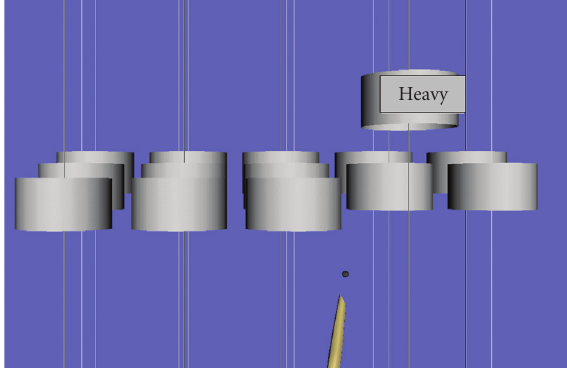
Figure 3: The stylus’s visual representation: a stick with a small black ball at its tip (the contact point). In this example, as the 2nd cylinder was pushed upward, a label “heavy” appeared on it simultaneously. As a cylinder moved past the end of the screen, it